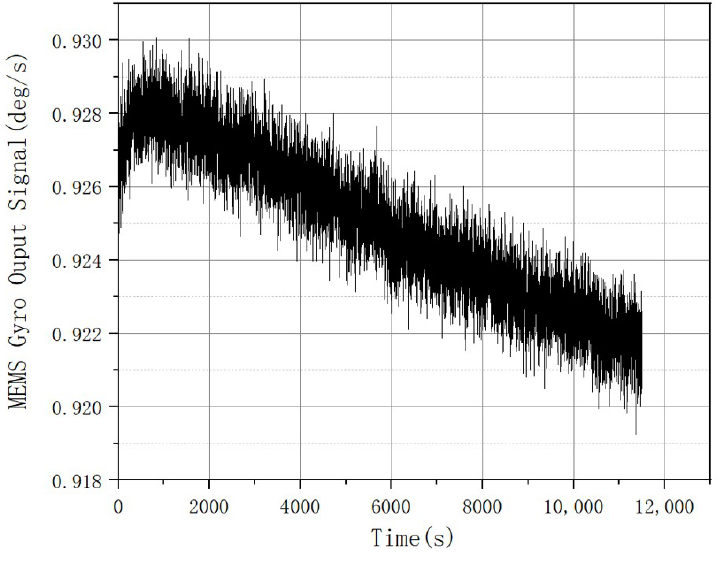
Figure 5. Original signal.